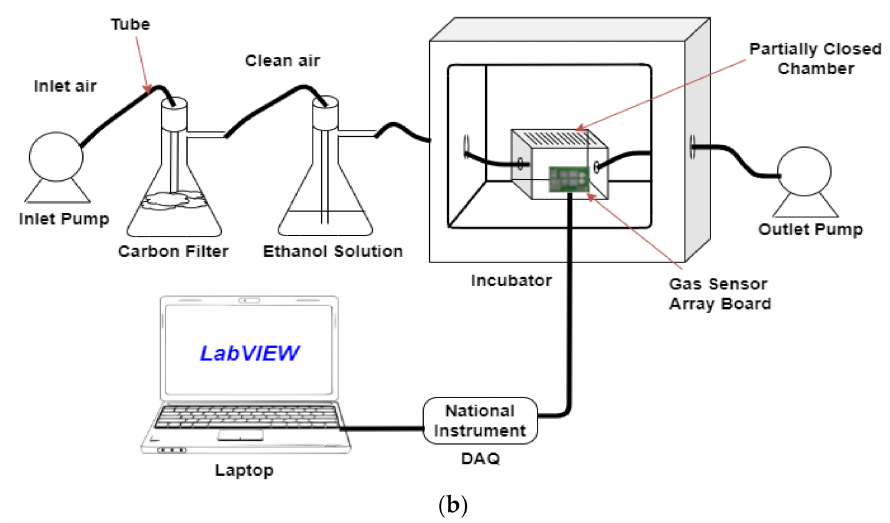
Figure 3. ( a ) Picture of hardware setup at incubator control; ( b ) schematic diagram for the experi- mental setup.